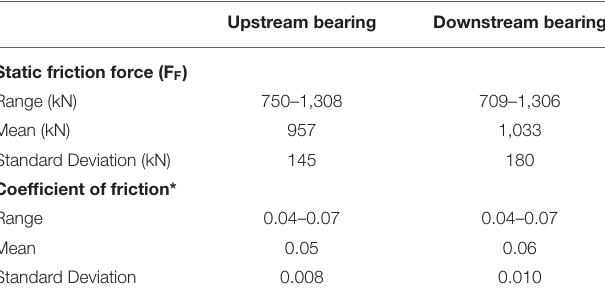
TABLE 1 | Pier A static friction